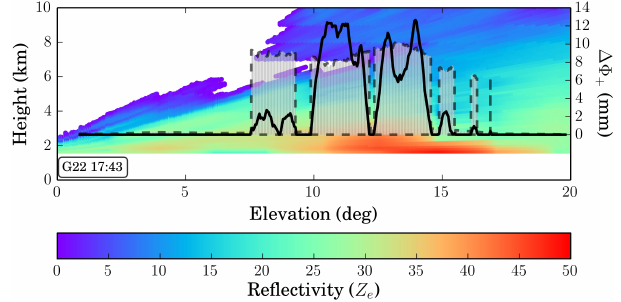
Figure 10. Each GNSS ray is identified by its elevation angle. Along a ray, each point can be identified by its height. The colour scale shows the weather radar reflectivity Z e interpolated along the GNSS rays. The black line is the observed (cid:49)(cid:56) + (right y axis). Sim- ulation results performed as described in Sect. 5 are represented by dashed lines. In the regions where actual data showed (cid:49)(cid:56) + > 0 , all hydrometeors are taken into account in the simulations. Otherwise, only rain is simulated. Note also that fully oriented ice crystals have been considered in the simulation; however, this orientation may not necessarily apply, as no information about the orientation of ice crystals is